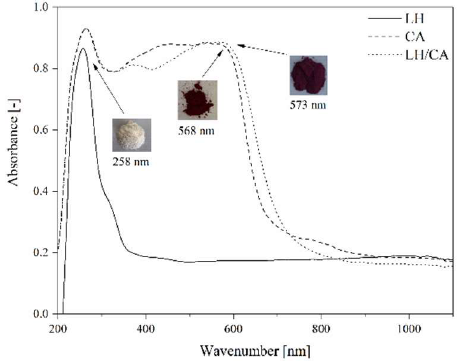
Figure 6. UV-Vis spectra of LH, carminic acid, and LH/CA 20%.